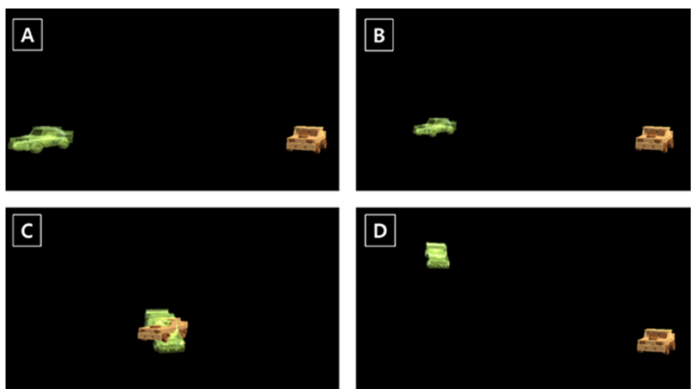
Figure 5. Pictures of each task about the target object (brown Car) and objective object (green Car). ( A ) The task of translating the target object (brown Car) to the objective object (green Car) along the y -axis (Manipulation 1). ( B ) The task of translating the target object (brown Car) to objective object (green Car) on the XY plane (Manipulation 2). ( C ) The task of rotating the target object (brown Car) to match the objective object (green Car) around the y- and -axes (Manipulation 3). ( D ) The task of translating and rotating the target object (brown Car) to match the objective object (green Car; Manipulation